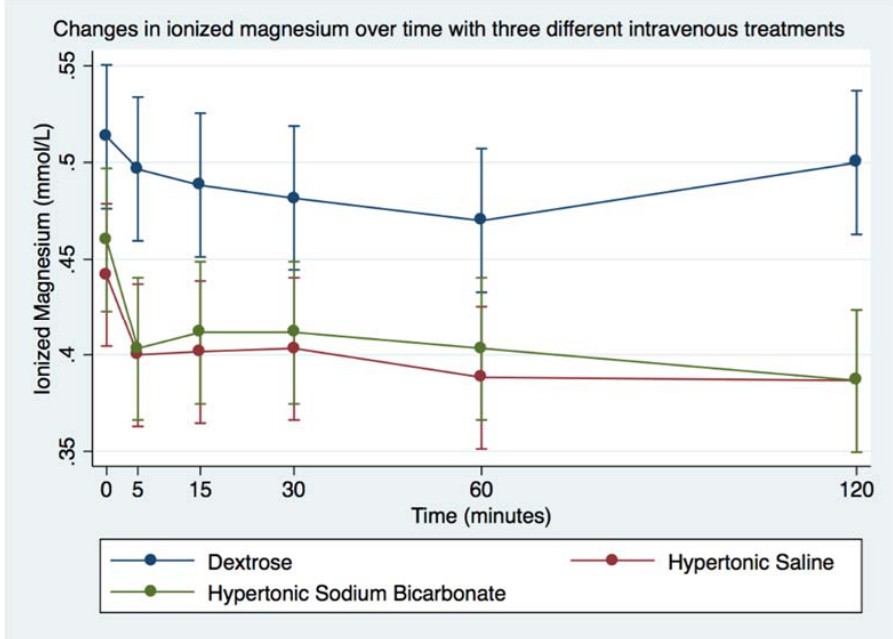
Figure 6. Overall effect of treatment on the blood ionized magnesium (Mg 2+ ) over time. The mean and SEM venous blood Mg 2+ for all six horses. Blue = Treatment Group DS (5% dextrose solution at 2 mL/kg bwt); Green = Treatment Group HB (NaHCO 3 8.4% solution at 2 mmol/kg bwt); and Red = Treatment Group HS (NaCl 7.5% solution at 4 mL/kg bwt).